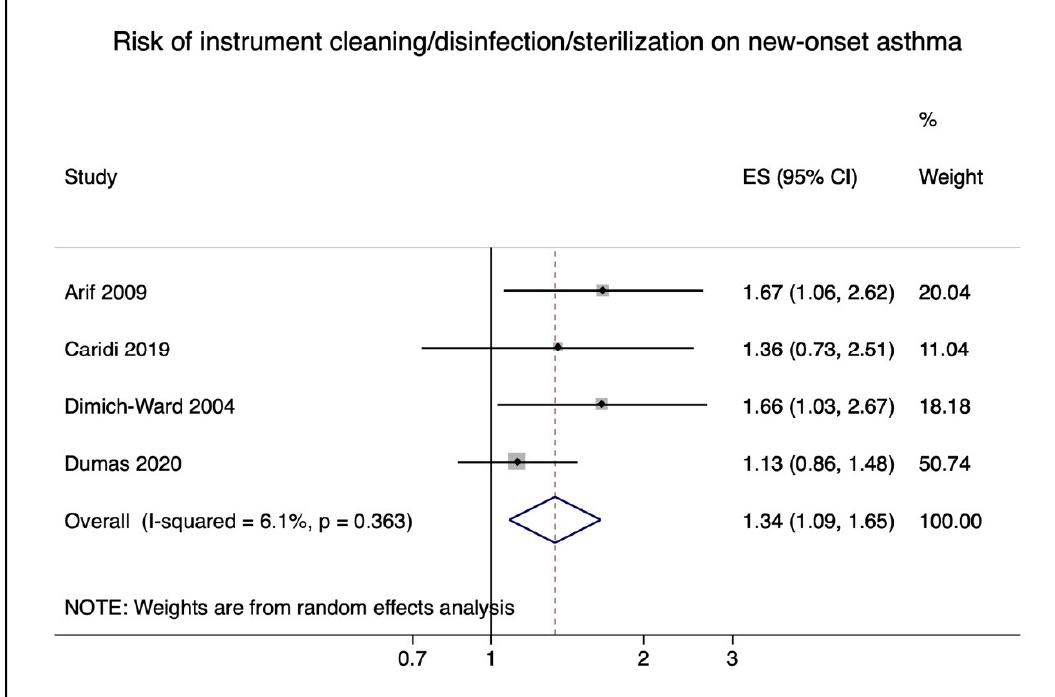
Figure 5. Pooled risk of cleaning/disinfecting/sterilization of instruments and medical equipment on new-onset asthma in nurses.